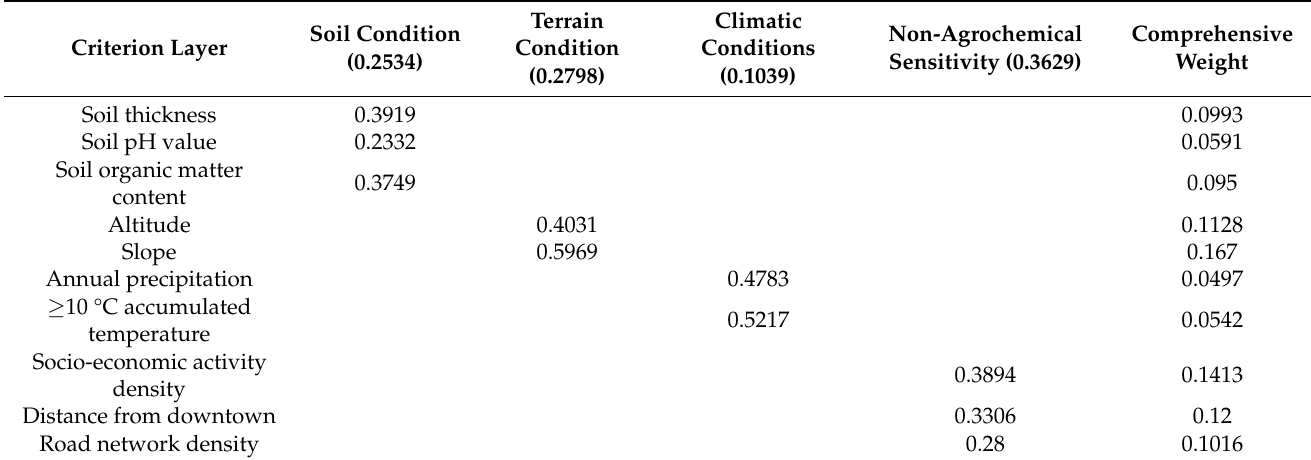
Table 4. Weights of FSE